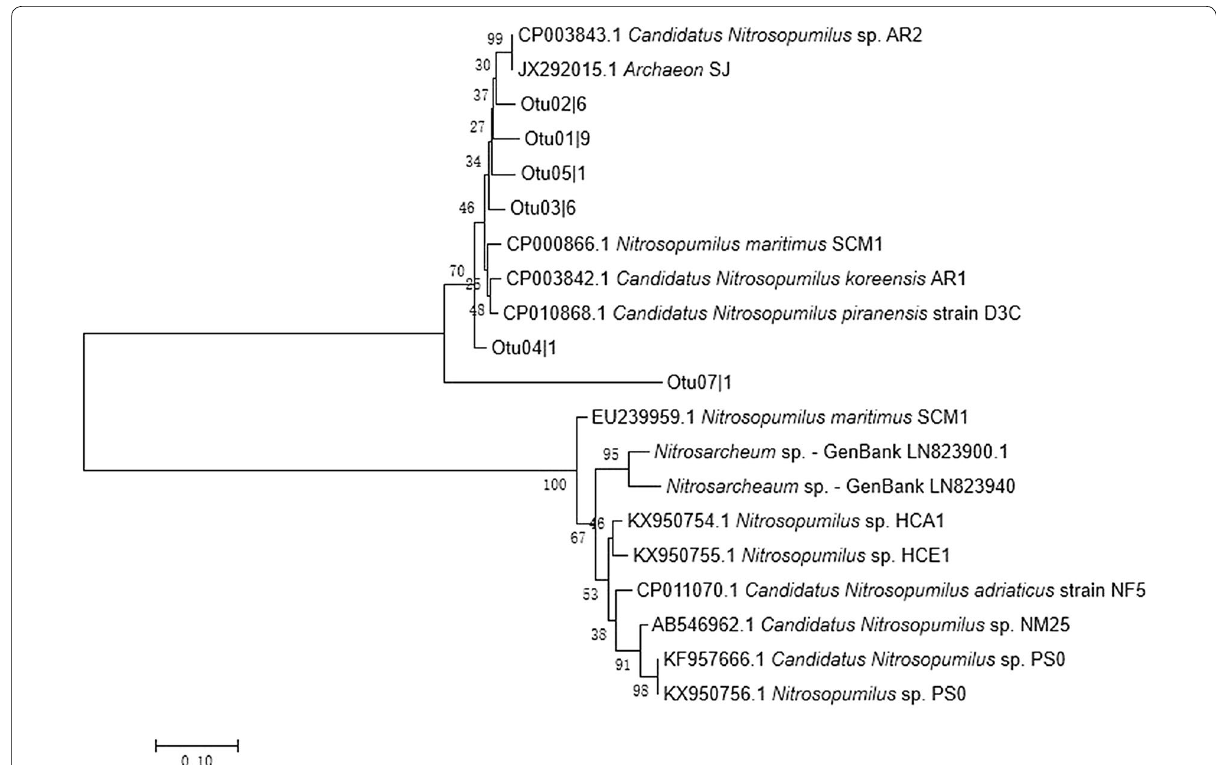
Fig. 3 Neighbor-joining tree for DNA sequences of amoA genes of ammonia-oxidizing archaea in recirculating aquaculture systems producing hybrid grouper. Numbers to left of nodes indicate bootstrap support for those nodes. The bar shows phylogenetic distance in numbers of nucleo- tide substitutions per